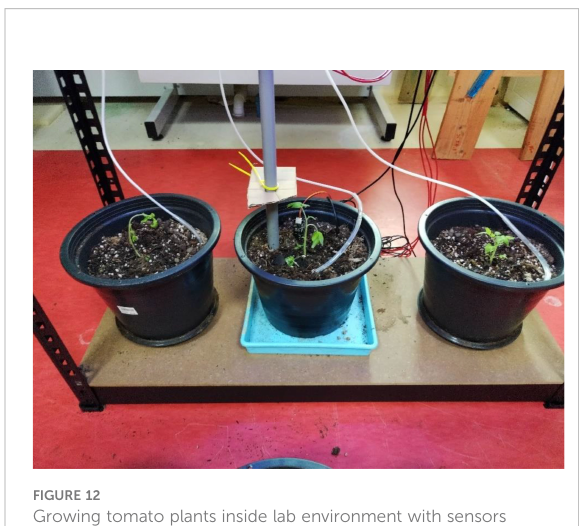
FIGURE 12 Growing tomato plants inside lab environment with sensors deployed in soil.